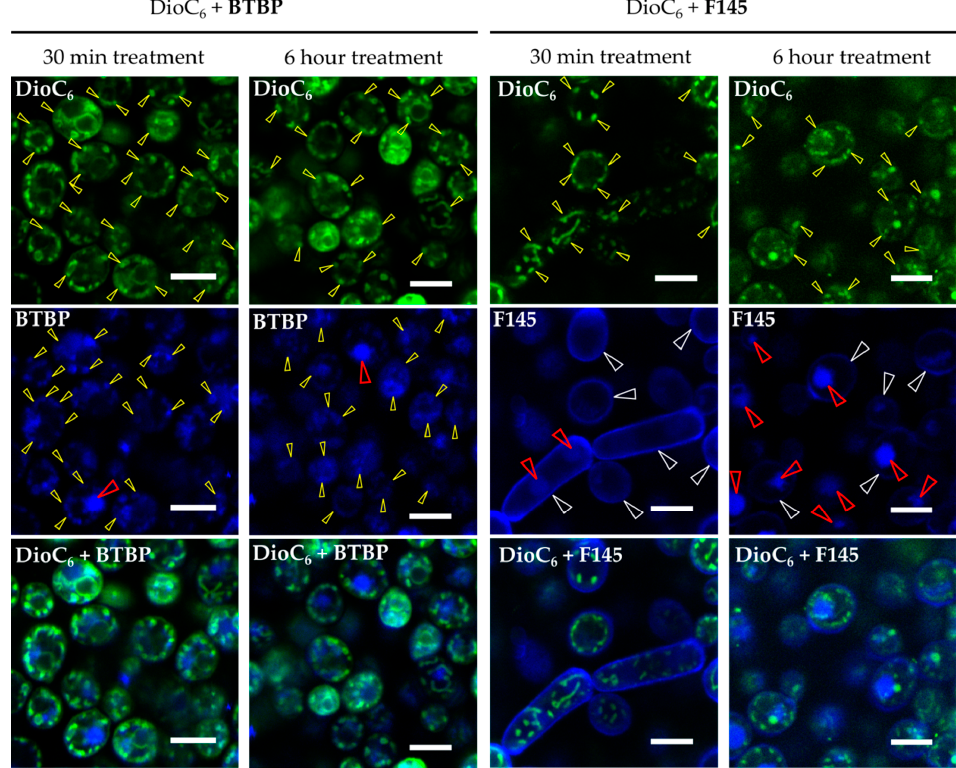
Figure 5. CLSM of C. albicans cells treated with DioC 6 (3) and F145 for either 30 min or 6 h; control treated with DioC 2 (3) and BTBP fluorophore for 30 min or 6 h, respectively. White arrows indicate the stained cell wall, yellow arrows show the stained mitochondria, and red arrows indicate the stained nucleus. Scale bar is 5 μ m.